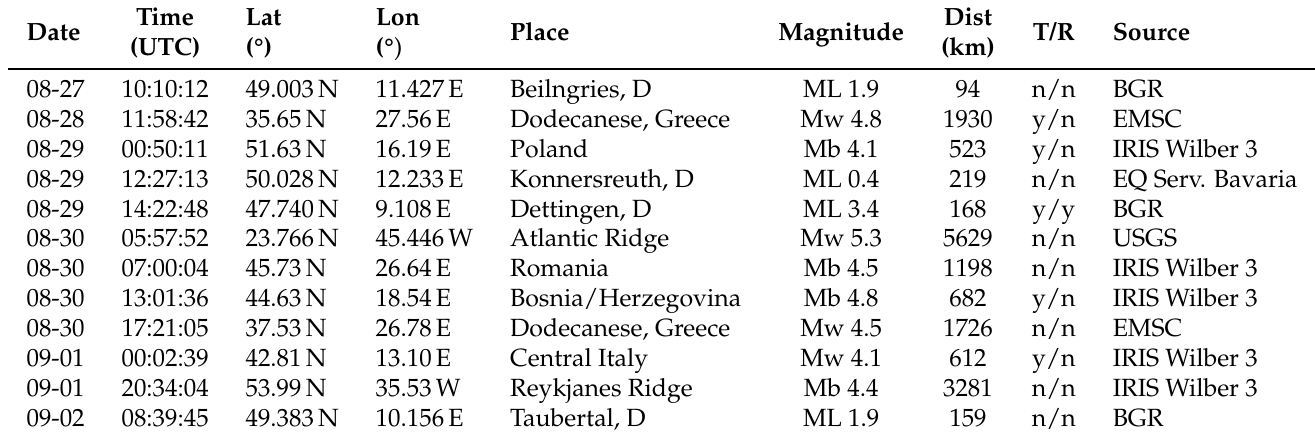
Table 2. Earthquakes within the time range of the huddle test. dist gives the distance of the earthquake to Fürstenfeldbruck. T/R states whether the event was recorded on translational and/or rotational